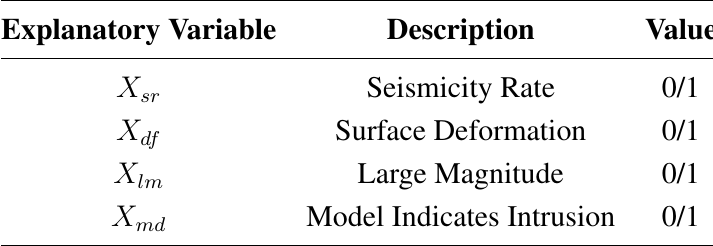
Table 2. Explanatory variable names, descriptions, and possible values for node